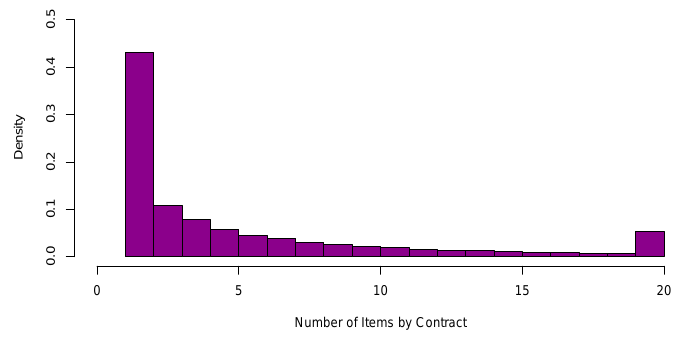
Figure 2. Distribution of the number of items by contract.